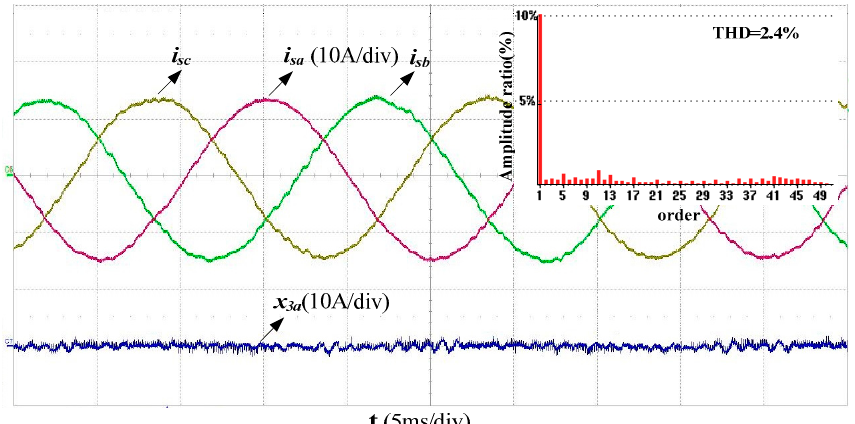
Figure 14. Experimental waveform of the grid current and harmonic error with MRSMC.